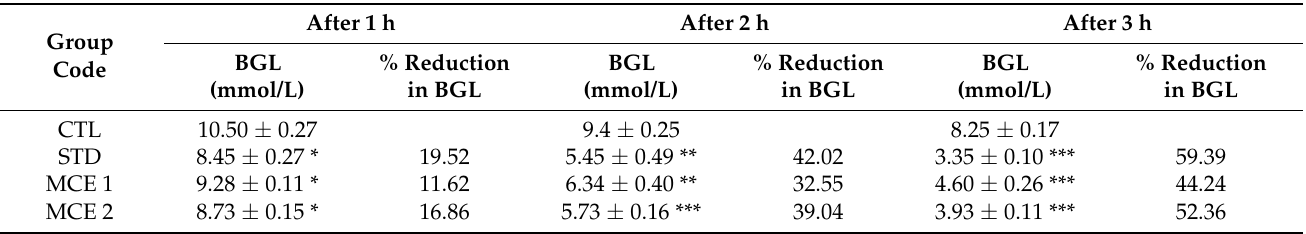
Table 3. The hypoglycemic activity of the methanolic crude extract of the W. tinctoria stem.